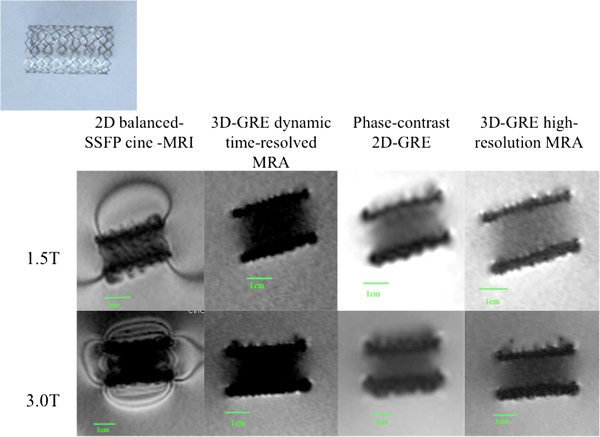
MR appearance of EV3 Transhepatic Biliary Stent (Devices 4-6).